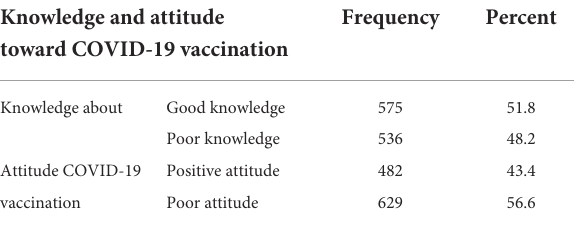
TABLE 3 Knowledge and attitude of the respondents toward COVID-19